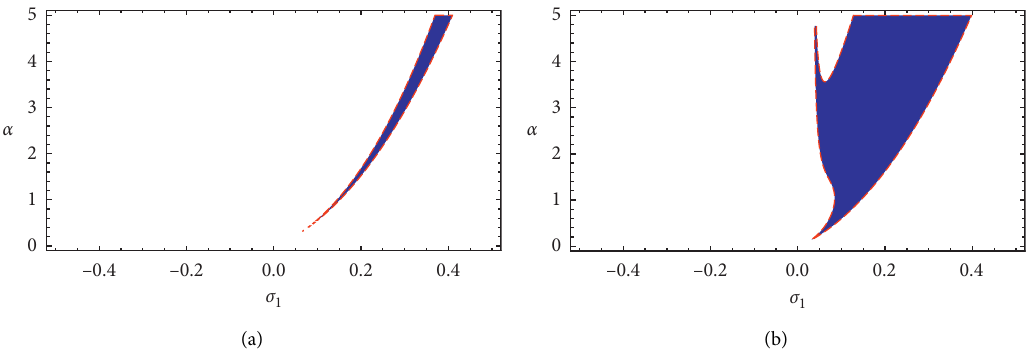
Figure 9: The system solution behavior in α − σ system with τ � τ